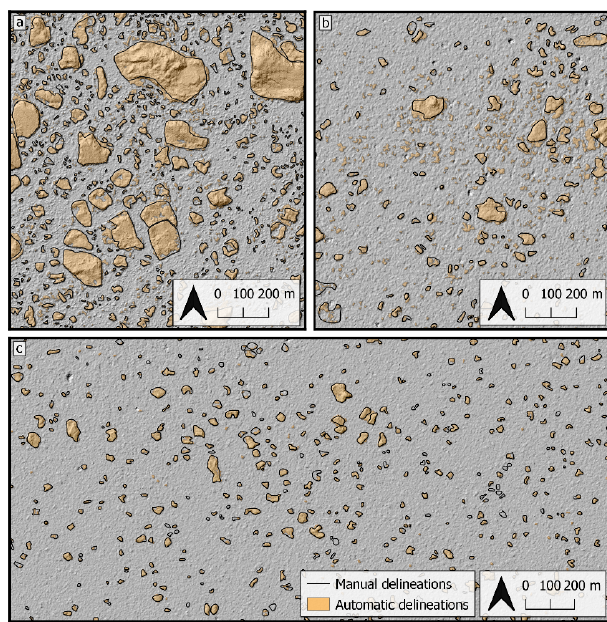
Figure 4. Manual (black lines) and automated (orange) delineations of the iceberg subset for (a) SKJI (10 September 2011), (b) UI (4 July 2012) and (c) KNS (21 August 2013) overlaying the hill- shaded ArcticDEM v3 strip data for each